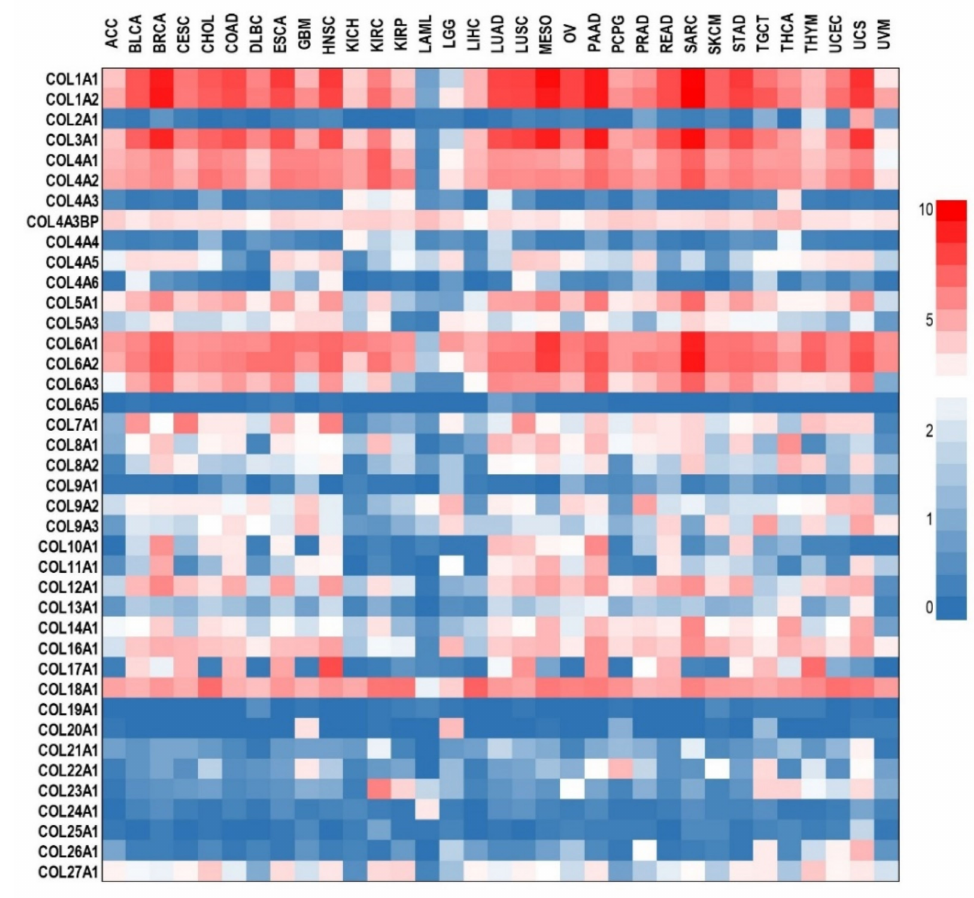
Figure 2. Differential expression analysis of collagens in various cancer types. RNA sequencing expression data from the TCGA and the GTEx projects were analyzed with GEPIA [87] and presented as a heatmap generated in GraphPad Prism 9. Data are expressed as log2(TPM + 1) (TPM-